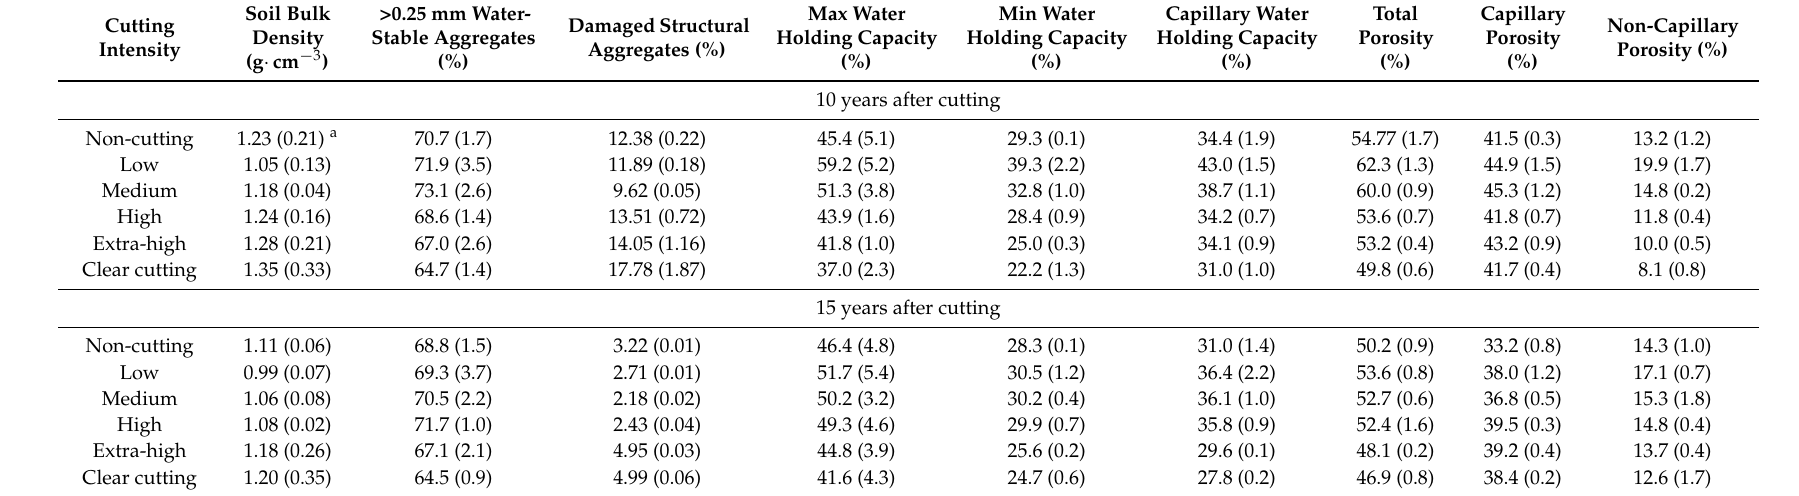
a Figures inside parentheses are standard